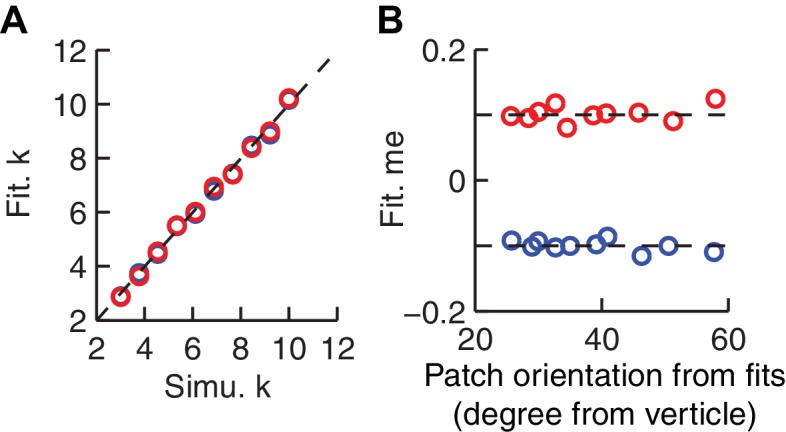
The HDDM model fitting procedure does not introduce spurious correlations between patch orientation and me value.Artificial sessions were simulated with fixed me values (±0.1 for the two reward contexts) and different k values. (A) Recovered k values from HDDM fitting closely matched k values used for the simulations. (B) Recovered me values from HDDM fitting closely matched me values used for simulation and did not correlate with RTrial patch orientation.